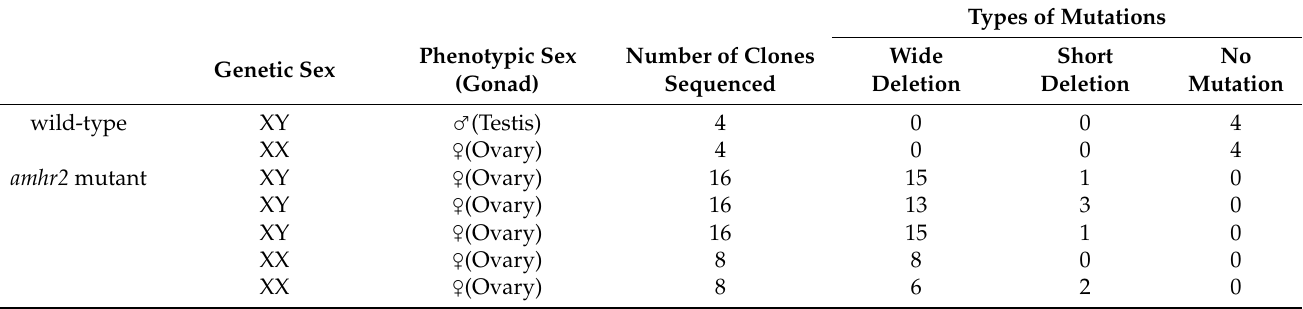
Figure 2. Construction of amhr2 -mutant Japanese flounder using the CRISPR/Cas9 system. Schematic of positions targeted by crRNAs on the amhr2 locus, showing exons (white boxes), introns (horizontal lines), and target positions (arrows) of the crRNAs with the CRISPR/Cas9 system ( A ). The target sequences of wild-type and amhr2 mutants ( B ). The horizontal lines and dashed lines indicate wild-type sequences and deletions, respectively. Slashes indicate omission of long sequences. The numbers beside the target sequences indicate the approximate size of deletion ( − ) or insertion (+). Table 1. The types of mutations in amhr2 knockout mutants .